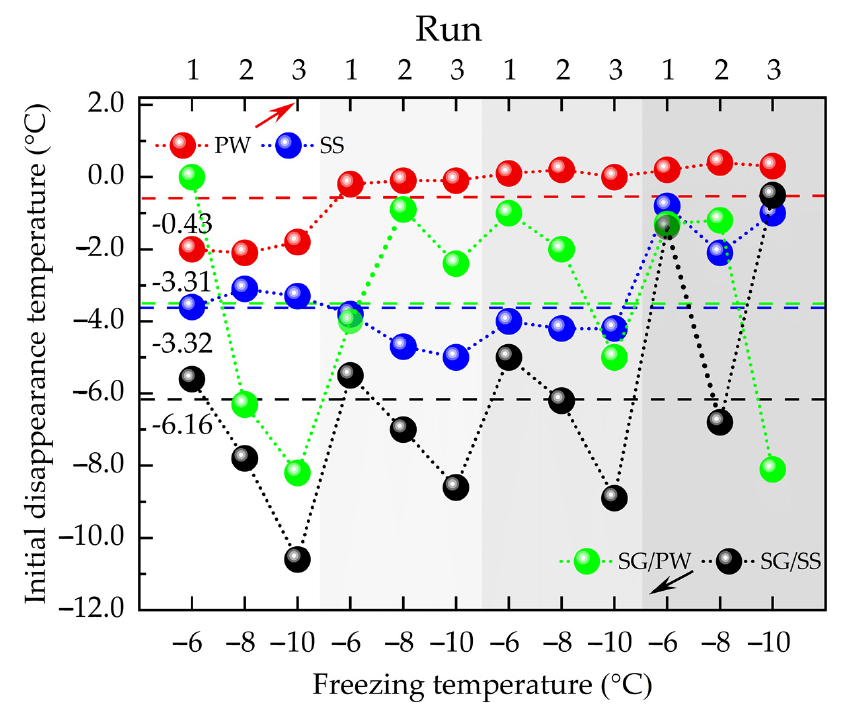
Figure 6. Measured initial disappearance temperatures (IDTs) of the self-preservation effect of hydrates formed in different runs. The four different colors in the background represent the design temperature (8.5, 6.5, 3.5, and 0.5 °C) from left to right.